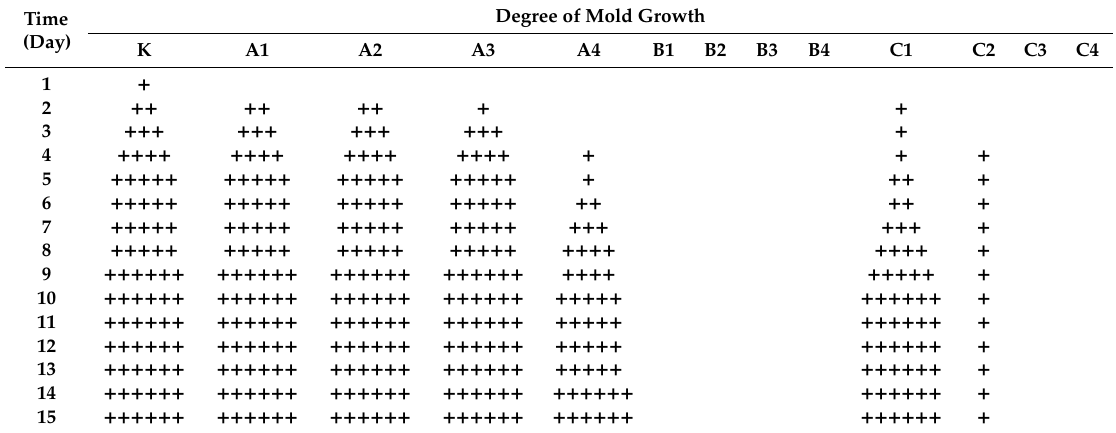
Degree of Mold Growth